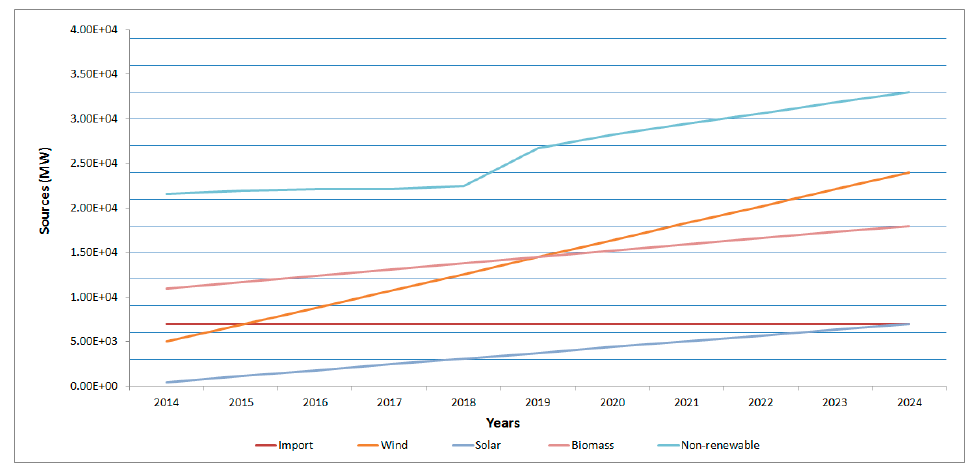
Figure 2. This figure shows the increase of the installed electricity capacity in Brazil (2014–2024)